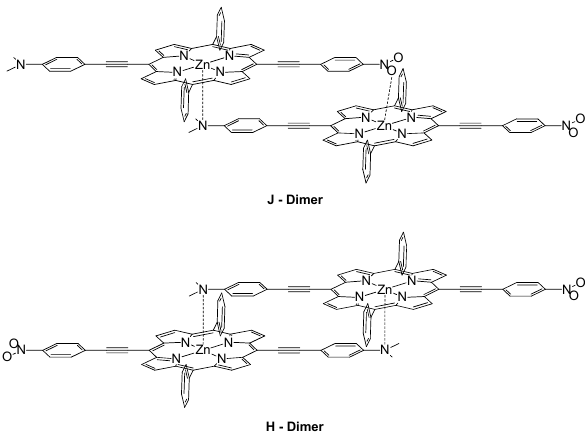
Figure 4. Suggested J and H aggregates of chromophore 3 . Adapted from J. Phys. Chem. C 2009 , 113 , 11131–11141. Table 3. EFISH μβ 1907 values as a function of the concentration and of the solvent for chromophore 3. Adapted from J. Phys. Chem. C 2009 , 113 , 11131–11141.